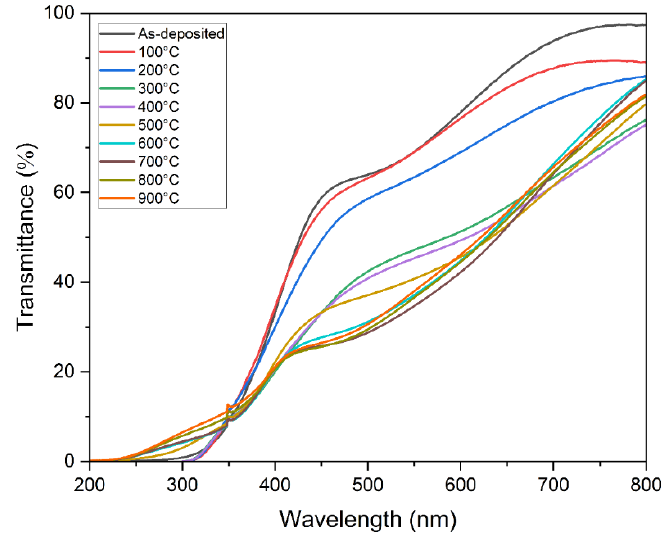
Figure 6. Optical transmission spectra of the CuGa 2 O 4 thin films annealed at different temperatures.